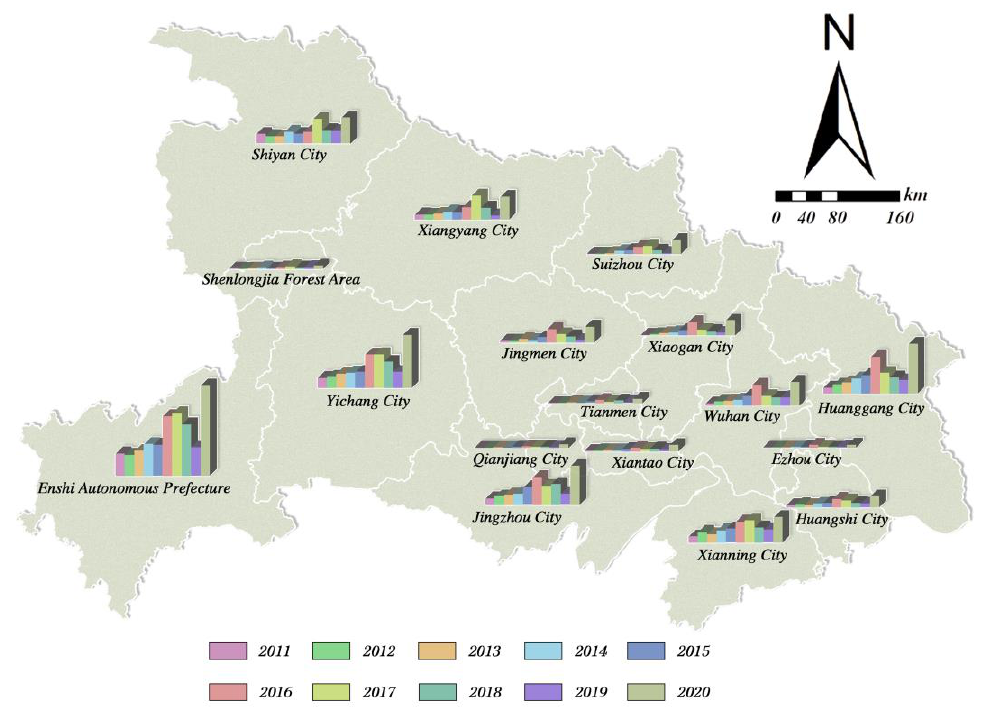
Figure 3. Total assets of water resources in Hubei Province from 2011 to 2020. The total water resource liabilities are presented in Table 6. Table 6. Total liabilities of water resources in Hubei Province from 2011 to 2020 (billion USD).